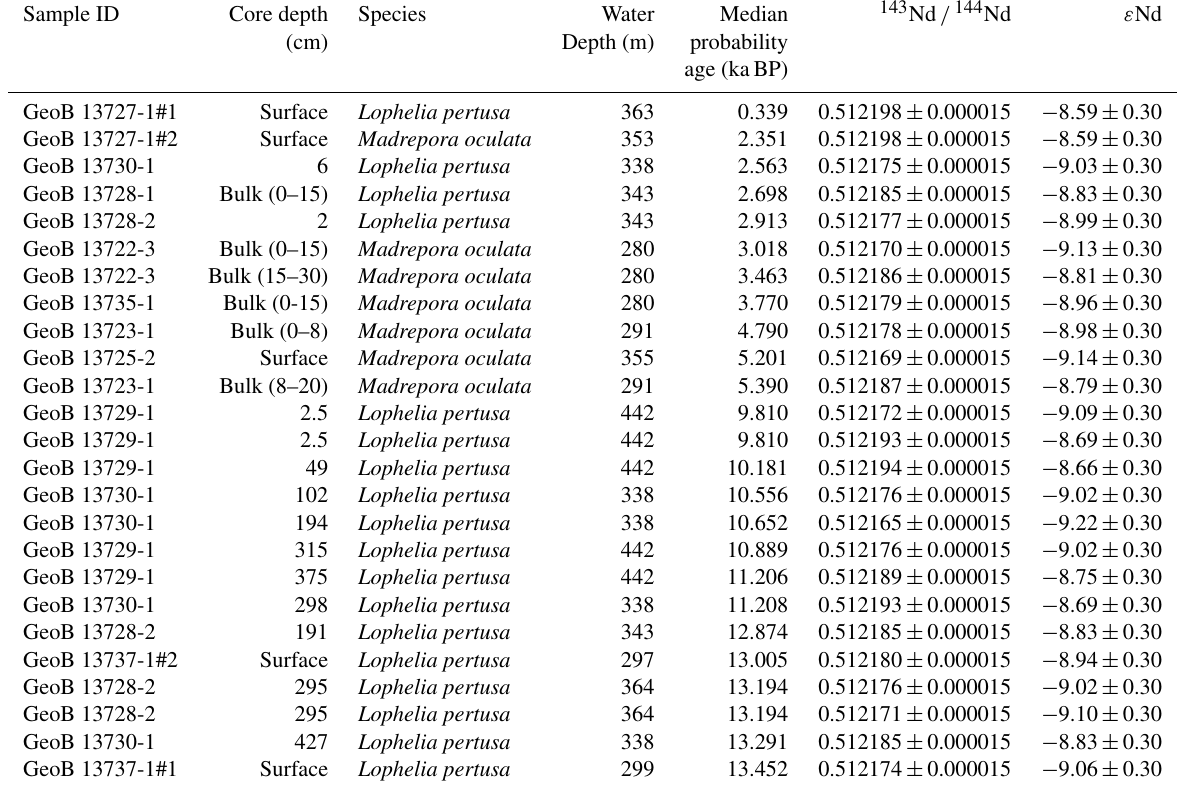
Table 2. ε Nd values obtained for cold-water corals from the southern Alboran Sea. The AMS 14 C ages published by Fink et al. (2013) are also reported as median probability age (kaBP).